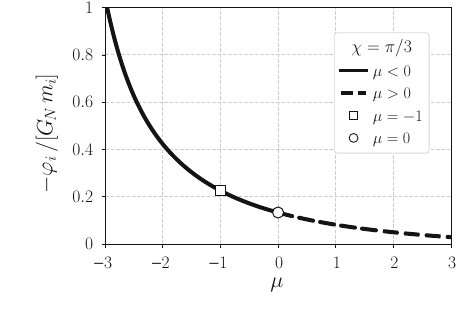
Fig. 2 Plot of Eq. (6.16) with fixed χ = π/